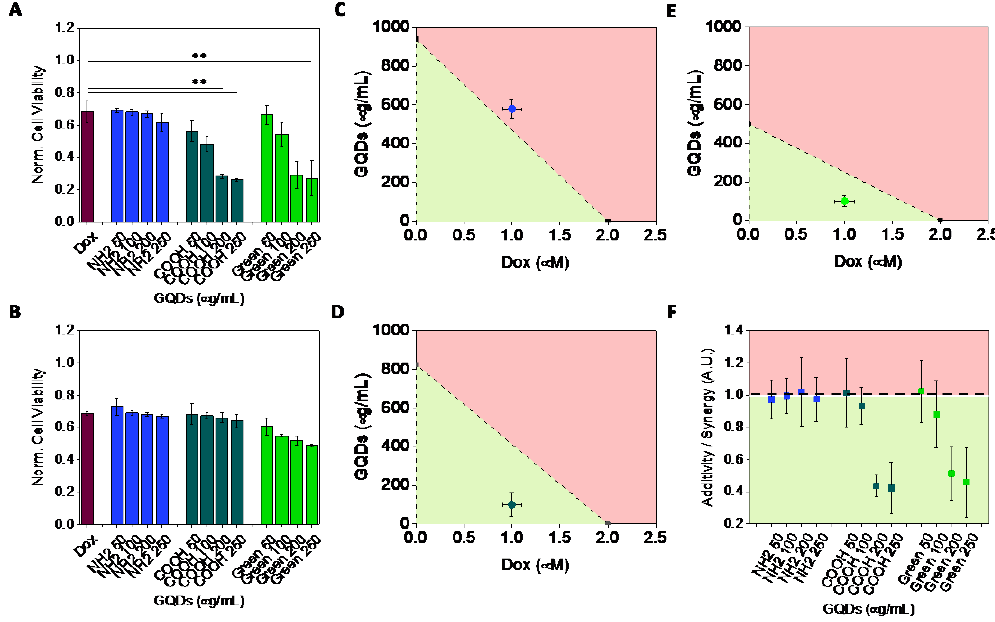
Figure 4. Synergy of GQDs and doxorubicin (Dox). Normalized cell viability for U87 ( A ) and cortical primary neurons ( B ) after the treatment with GQDs and Dox separately. Isoboles’ graphs of Dox with NH 2 , COOH, and Green-GQDs, respectively, on U87, to determine the presence of synergistic effects ( C – E ). Synergy expressed as the ratio between the theoretical additive effect of GQDs with Dox and the measured effect ( F ). ** p < 0.01, one-way ANOVA, and Tukey post hoc test.